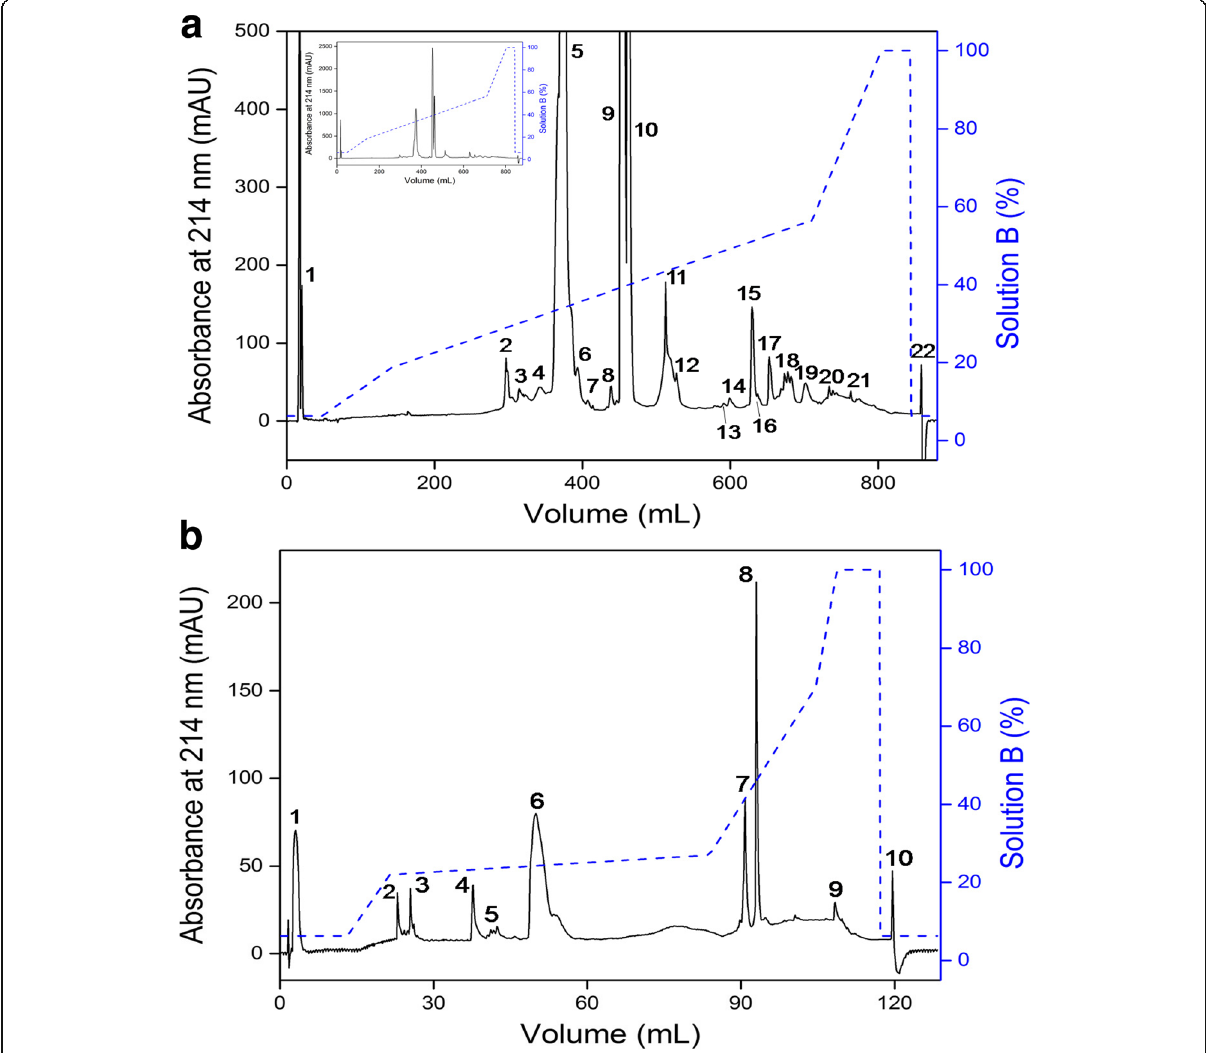
Fig. 1 Chromatographic profiles of non-RGD disintegrin from C. d. collilineatus venom using RP-FPLC system. a C. d. collilineatus venom (30 mg) was applied on a C18 column (250 × 10 mm, 5 μ m particles, 300 Å), at a flow rate of 5 mL/min and ( b ) Fraction 2 (200 μ g) on a C18 column (250 × 4.6 mm, 3.6 μ m particles), at a flow rate of 0.5 mL/min. Elution in both chromatograms was carried out in a segmented concentration